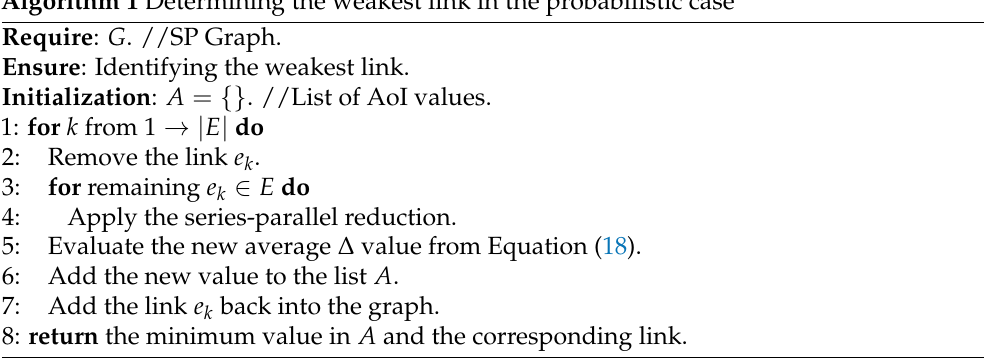
Algorithm 1 Determining the weakest link in the probabilistic